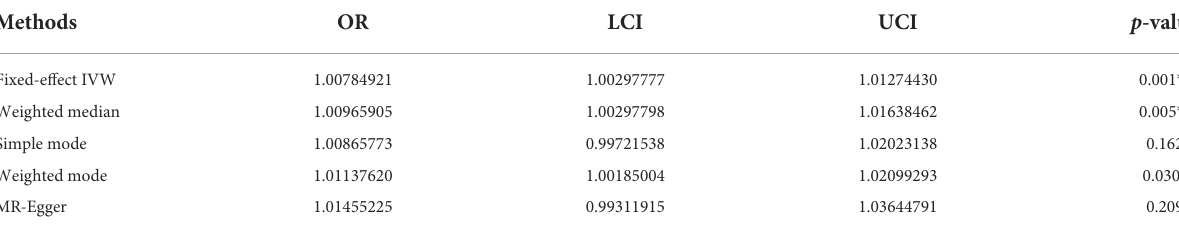
TABLE 2 Association of frailty index with vestibular disorders using various